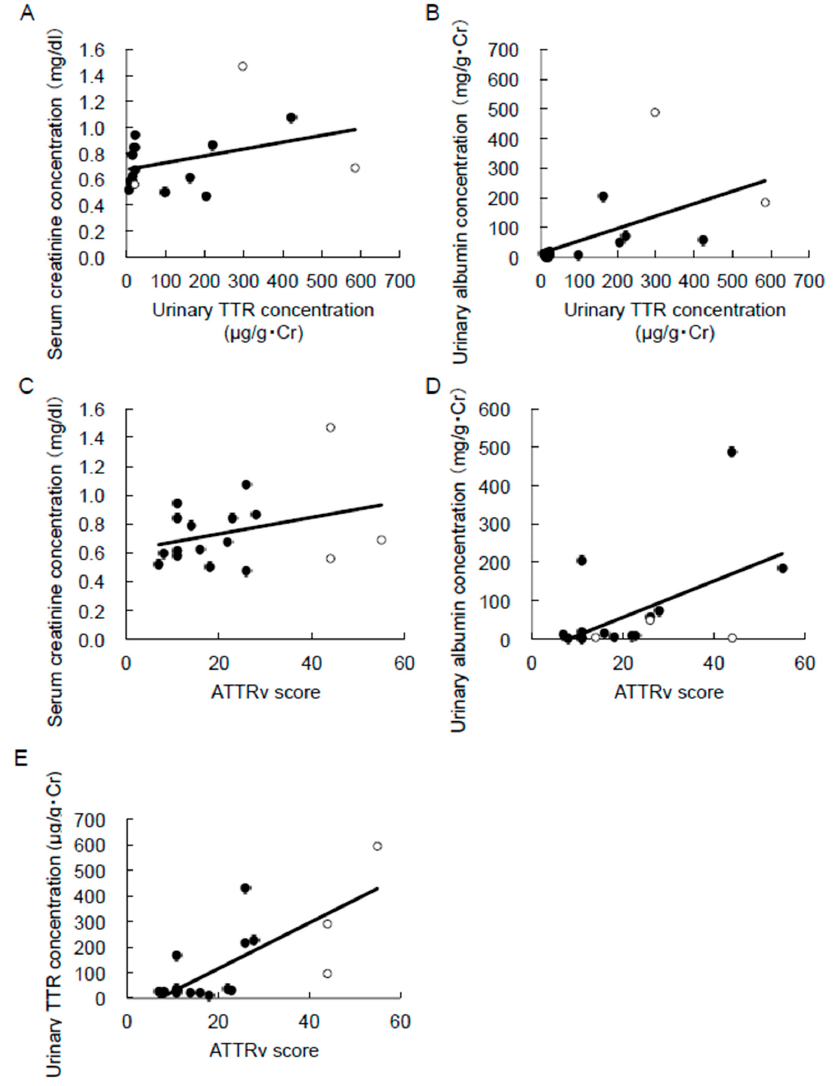
Figure 2. Correlation between urinary TTR concentrations and kidney function markers. ( A ) Serum creatinine concentration ( n = 17, r = 0.358, p = 0.110), and ( B ) urinary albumin concentration ( n = 17, r = 0.570, p < 0.016) versus urinary TTR concentrations of ATTRv. ( C ) Serum creatinine concentration ( n = 17, r = 0.319, p = 0.211), ( D ) urinary albumin concentration ( n = 17, r = 0.531, p < 0.028), ( E ) urinary TTR concentrations ( n = 17, r = 0.741, p < 0.0006) versus the ATTRv score. The correlation coefficient ( r ) is shown. White circles—late